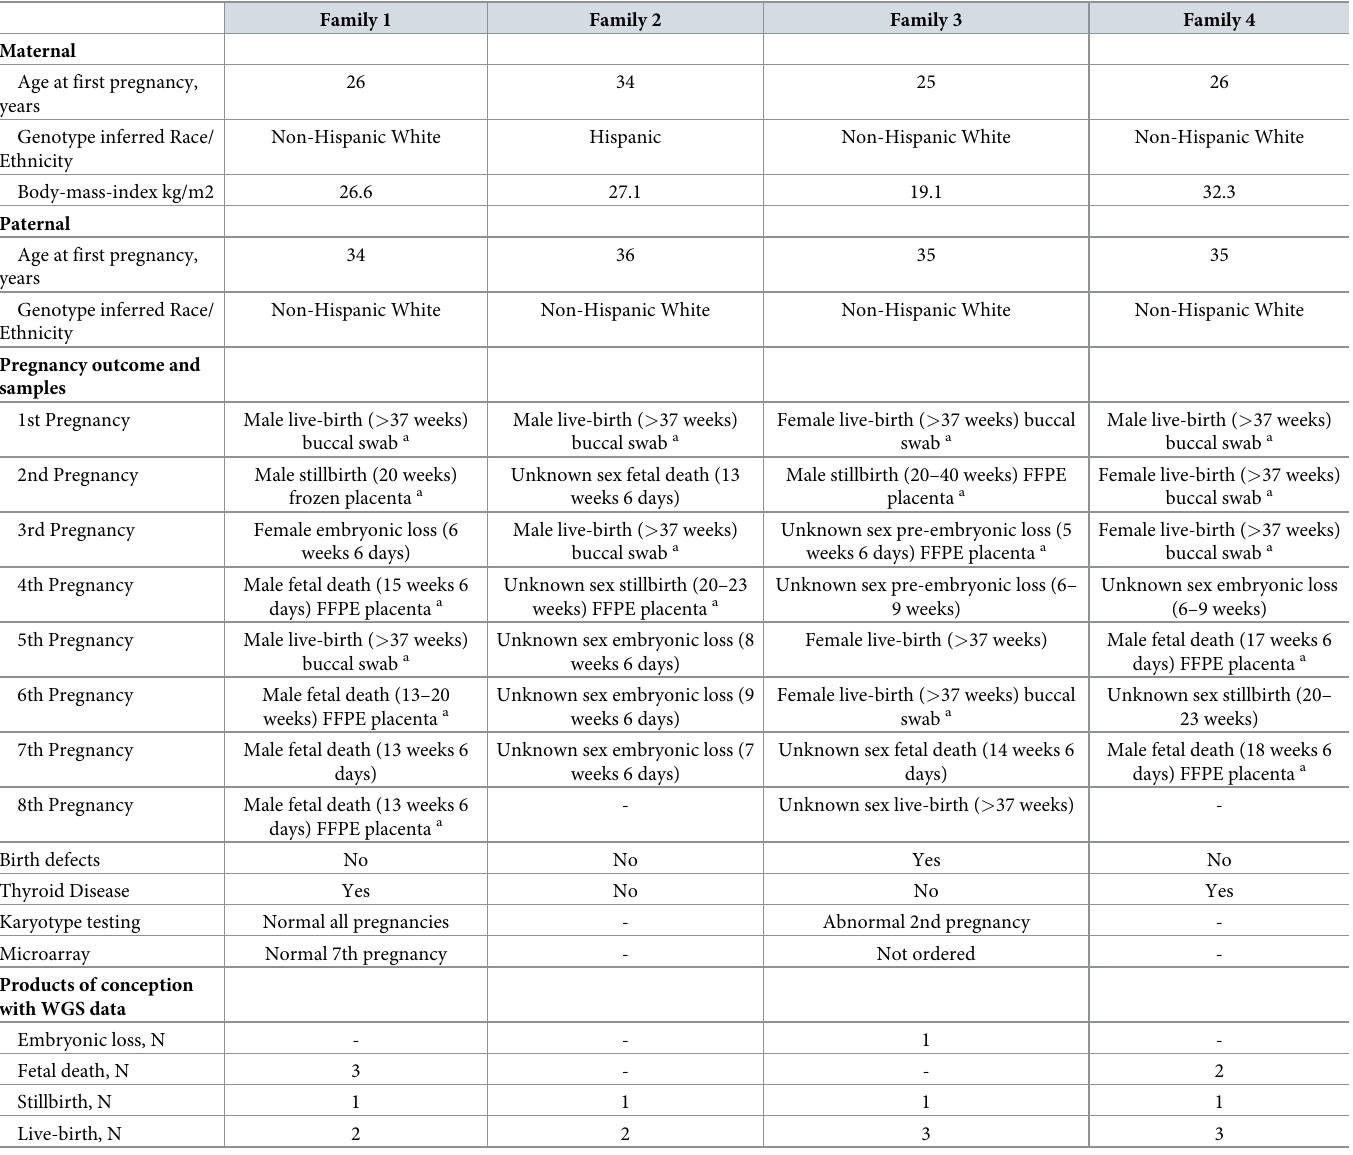
Table 1. Characteristics of study